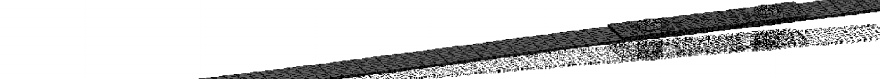
Fig. 9. Mesh of investigated structure with attached friction damper (example deformation and undeformed reference).